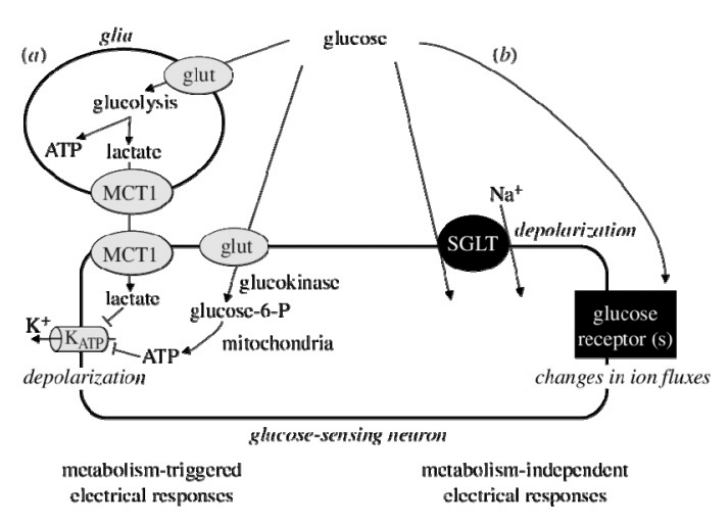
Fig. 3 Energy Consumption before and after Baduanjin and Ninth Broadcast